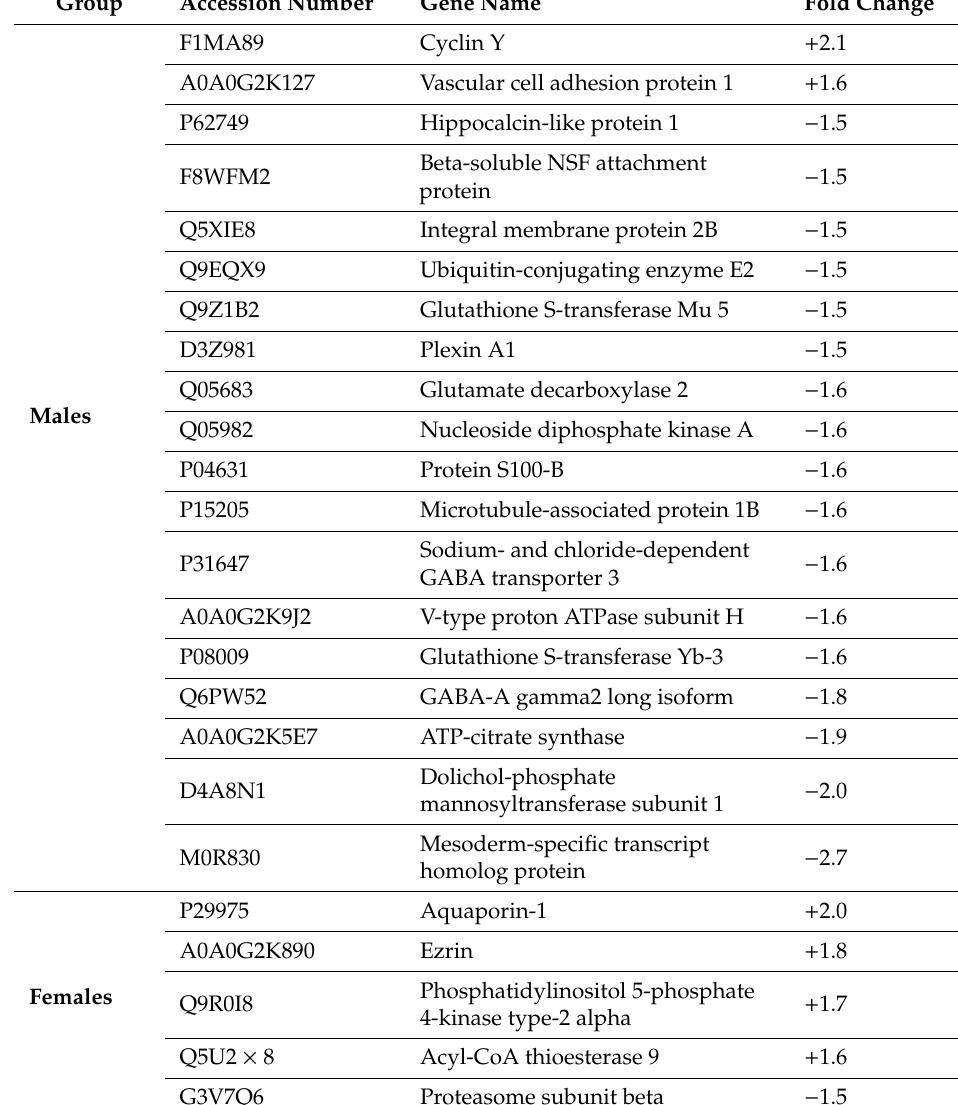
Table 1. Significant proteins di ff erentially expressed between males and females after nicotine self-administration. A criterion of 2 + unique peptides and fold change of > 1.5 was used to select the potential